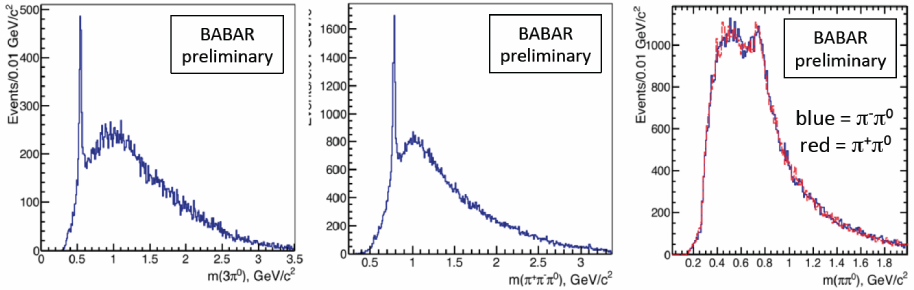
Figure 9. The dominant intermediate resonance structure observed in e + e − → π + π − π 0 π 0 π 0 events: peaks at the (left) η → 3 π 0 , (center) ω → π + π − π 0 , and (right) ρ ± → π ± π 0